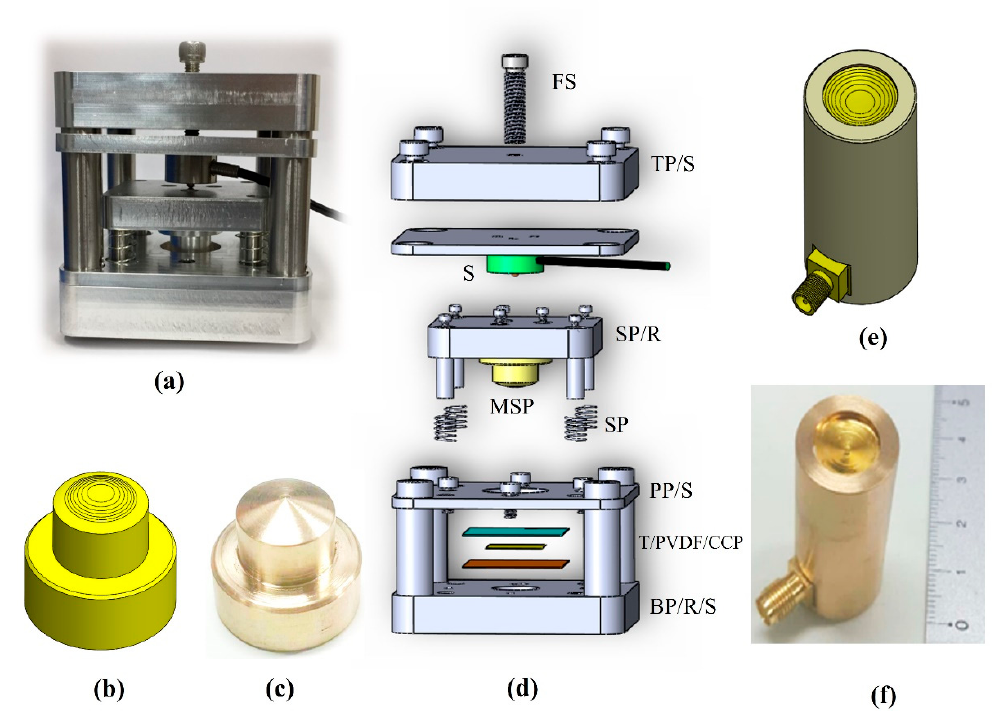
Figure 3. (a) A photograph of the press-fit structure; ( b ) the designed multi-spherical pattern (MSP); (c) a photograph of the MSP; (d) the press-fit’s components: base plate/rod/screw